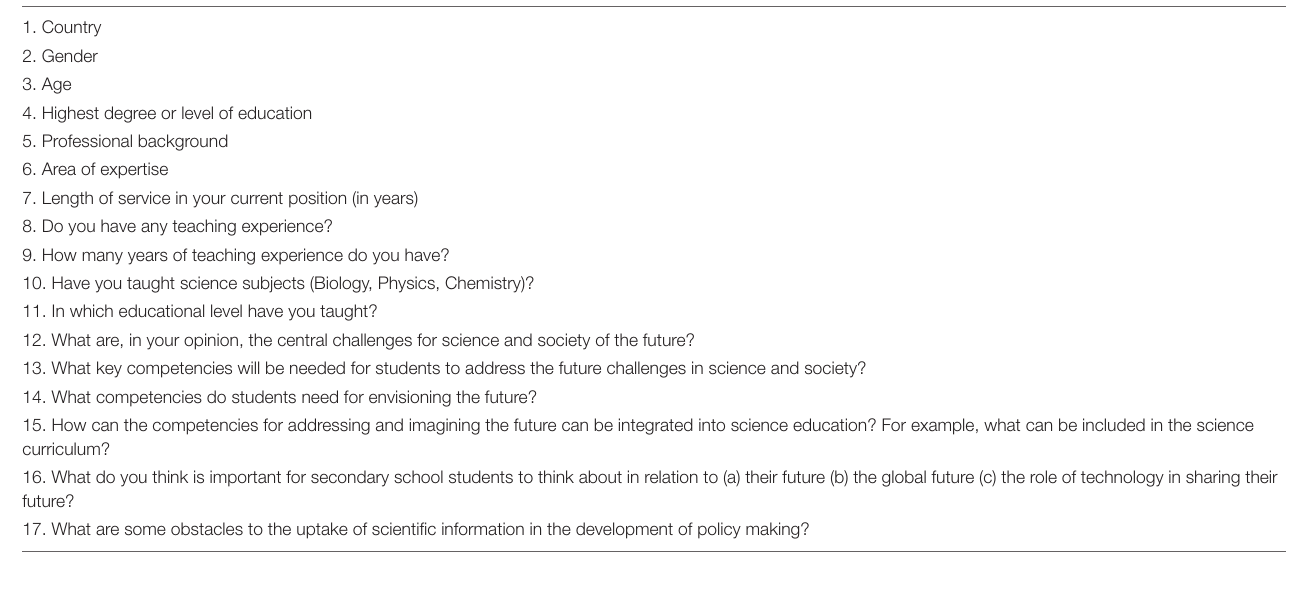
TABLE A1 | Open-ended items used in policymakers’ views